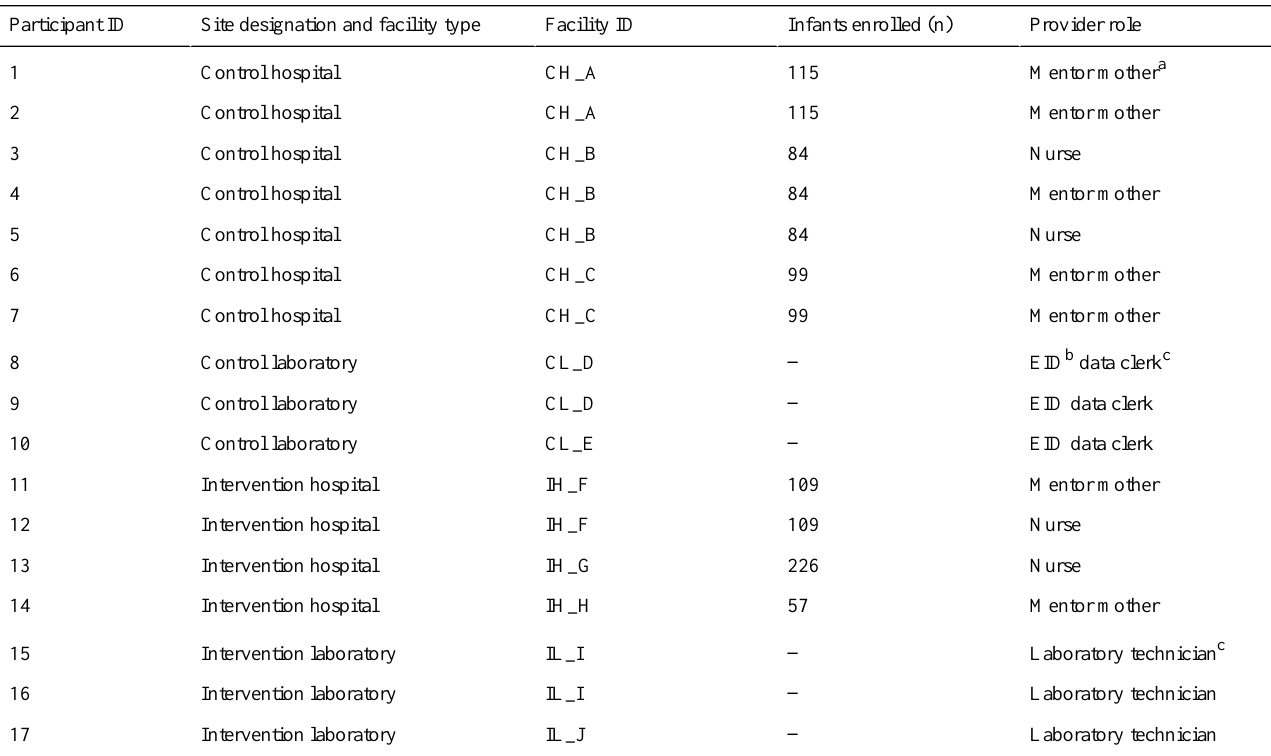
Table 1. Description of